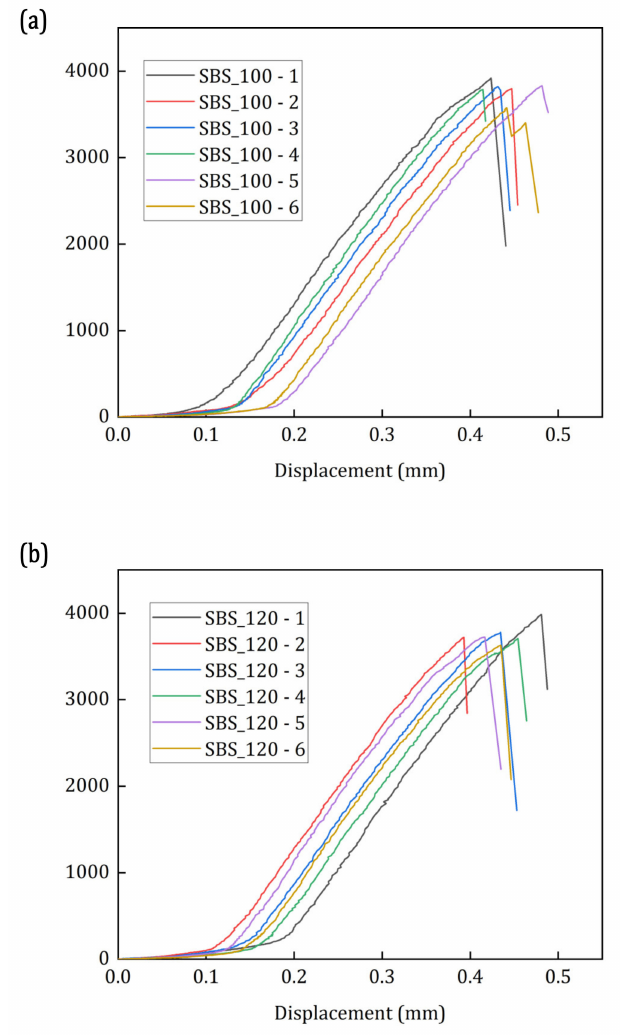
Figure 2. Load–Displacement curves of the SBS specimens tested at ( a ) 100 ◦ C and ( b ) 120 ◦ C. Table 2. ILSS Properties of Plain Weave Fabric CFRP specimens tested at 100 ◦ C and 120 ◦